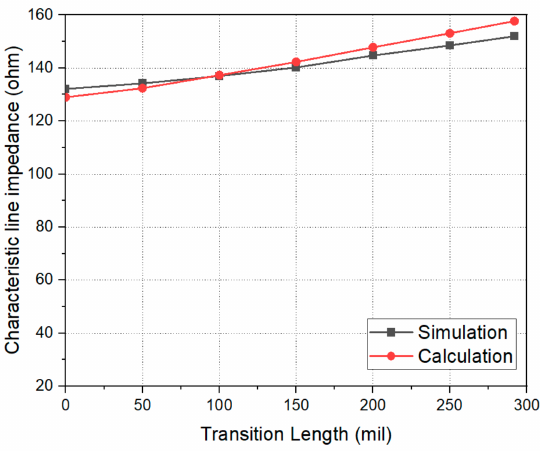
Figure 4. Calculated and simulated characteristic line impedances of the CPS taper ( AA (cid:48) to BB (cid:48) ). From BB (cid:48) to CC (cid:48) , the lower CPS line is connected to the upper CPS line using two